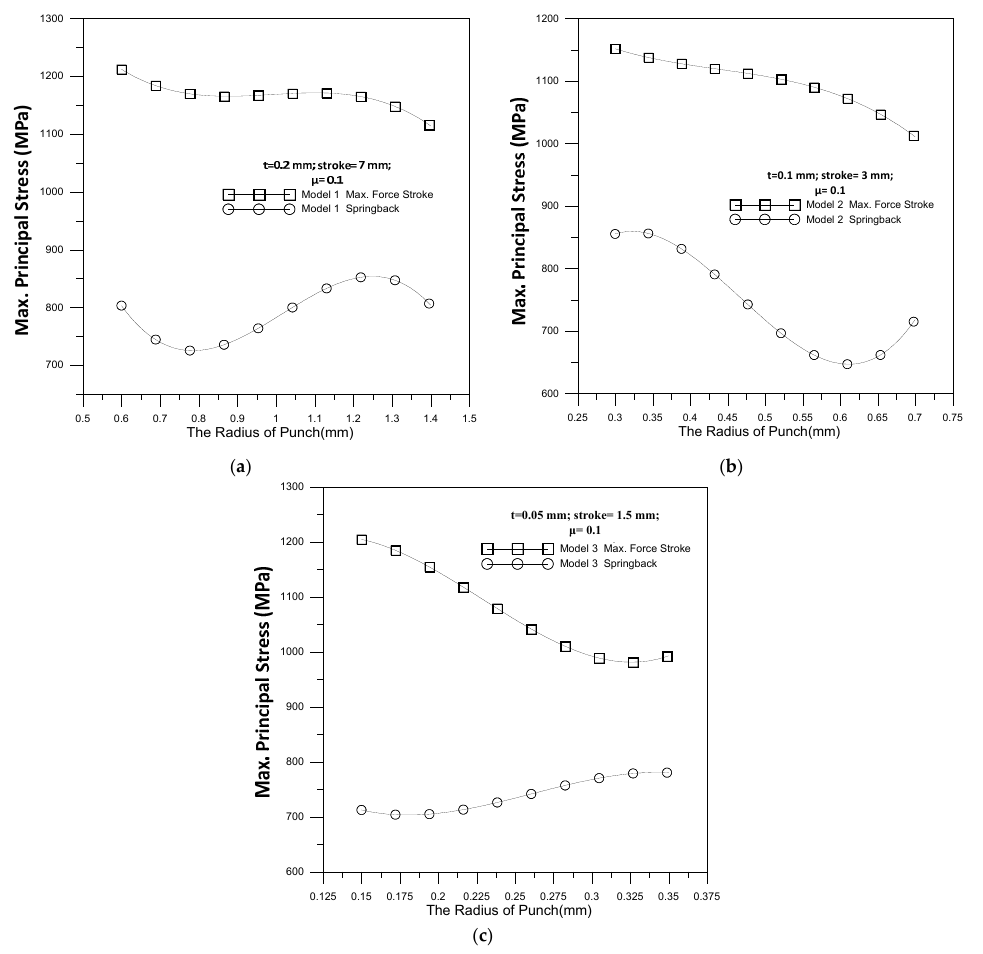
Figure 11. The relationship between the punch fillet radius and maximum principal stress: ( a ) Model 1; ( b ) Model 2; ( c ) Model 3.